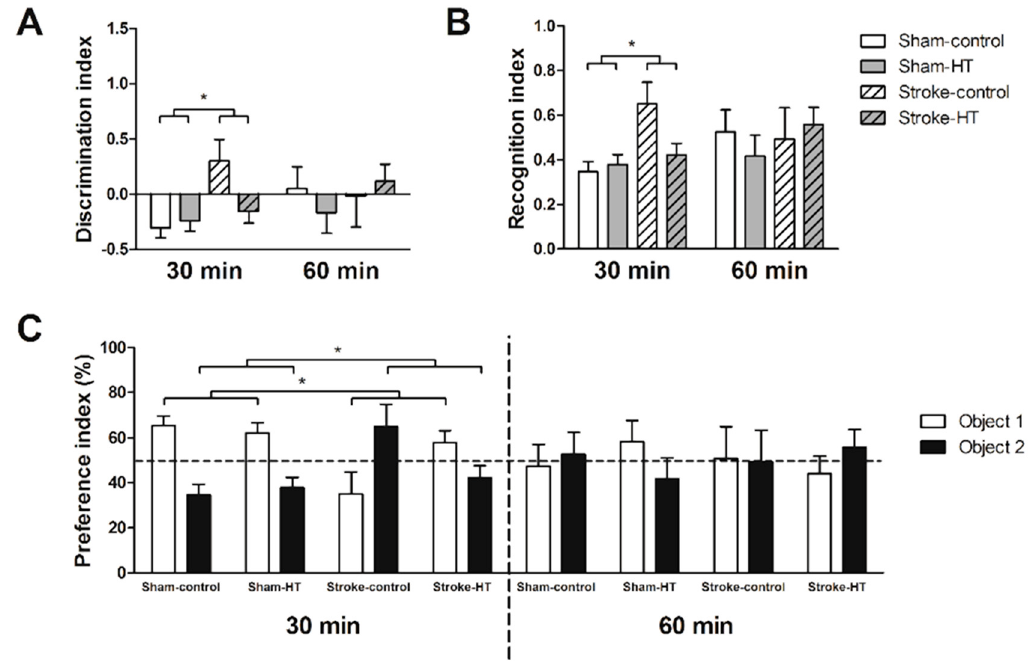
Figure 8. Familiarization phase object recognition test (ORT). Short-term memory of sham and stroke mice assessed by the novel ORT. ( A ) Discrimination index, ( B ) Recognition index, and ( C ) preference index. ( A – C ) Stroke animals had a preference for object 2 and sham animals a preference for object 1 ( p < 0.026). Values represent mean ± SEM. * p < 0.05.